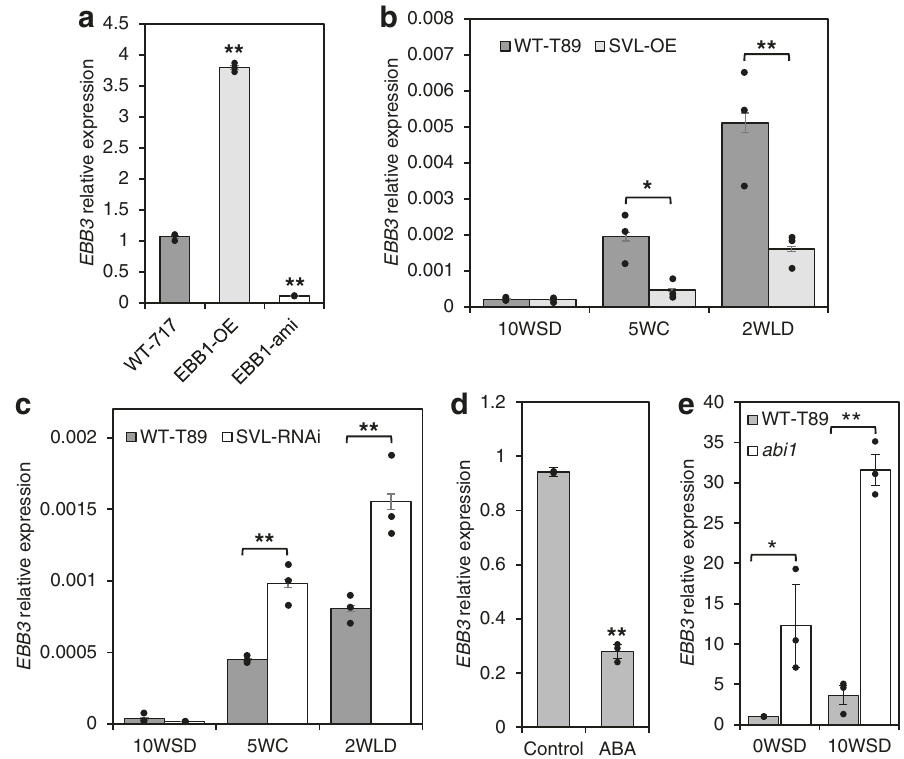
Fig. 5 EBB1, SVL, and ABA regulate the expression of EBB3 . a Relative expression of EBB3 in EBB1 over-expressing and under-expressing plants. Relative expression of EBB3 in SVL over-expressing ( b ) and under-expressing ( c ) plants. d Relative expression of EBB3 in ABA-treated apices of WT-717 plants. e EBB3 expression in apices of transgenic hybrid aspen with reduced ABA response ( abi1 mutant); 0W: time point before inductive treatments, 10WSD: 10 weeks under SD photoperiod, 5WC: 5 weeks under cold, 2WLD: 2 weeks under LD photoperiod and warm temperature. Expression values are the average of three biological replicates ±SEM, normalized to the reference genes - UBQ for WT-T89 and ACT7 for WT-717 clones respectively. Asterisks (*) indicate signi fi cant and (**) indicate extremely signi fi cant differences compared to WT at P < 0.04 and P < 0.001 respectively and determined using two- tailed paired multiple t